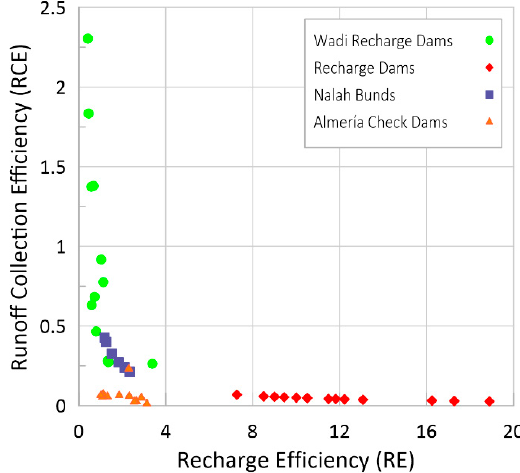
Figure 5. Runoff collection efficiency vs. recharge efficiency by type of recharge dam. Figure 5. Runo ff collection e ffi ciency vs. recharge e ffi ciency by type of recharge